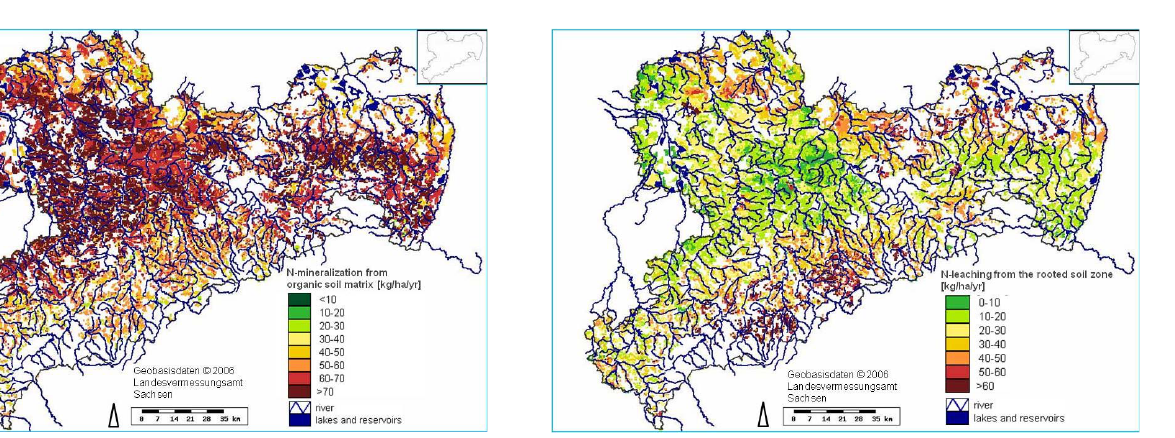
Fig. 6. N-leaching rate from the rooted soil zone on arable land in